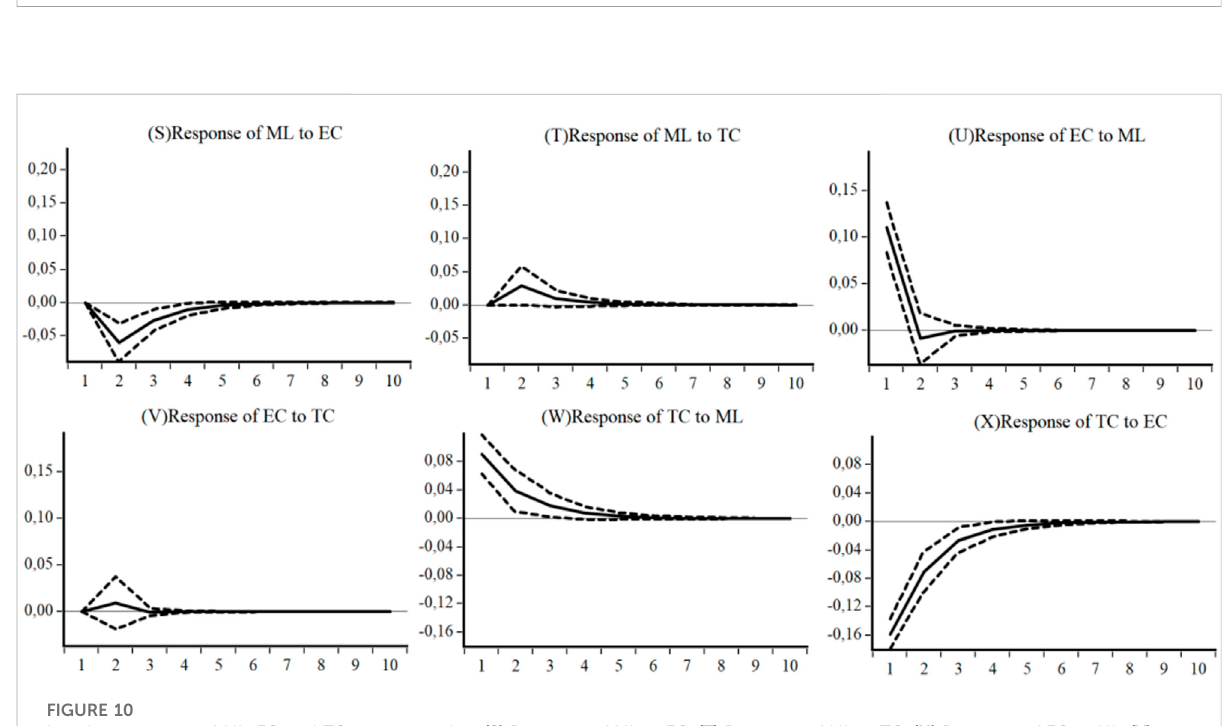
FIGURE 10 Impulse responses of ML , EC , and TC , western region. (S) Response of ML to EC, (T) Response of ML to TC, (U) Response of EC to ML, (V) Response of EC to TC, (W) Response of TC to ML, (X) Response of TC to